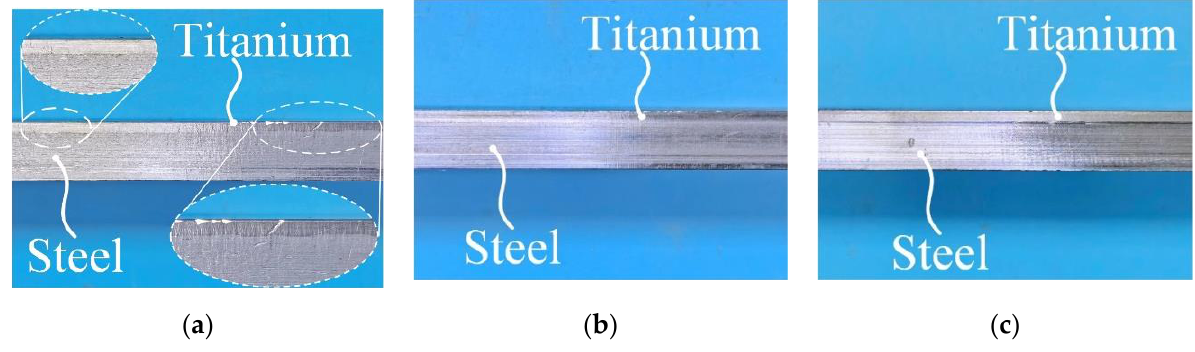
Figure 2. Interfacial conditions in different types of the TC bimetallic steels: ( a ) explosion-bonded specimen; ( b ) hot-rolled bonding specimen with low bonding strength; and ( c ) hot-rolled bonding specimen with high bonding strength.